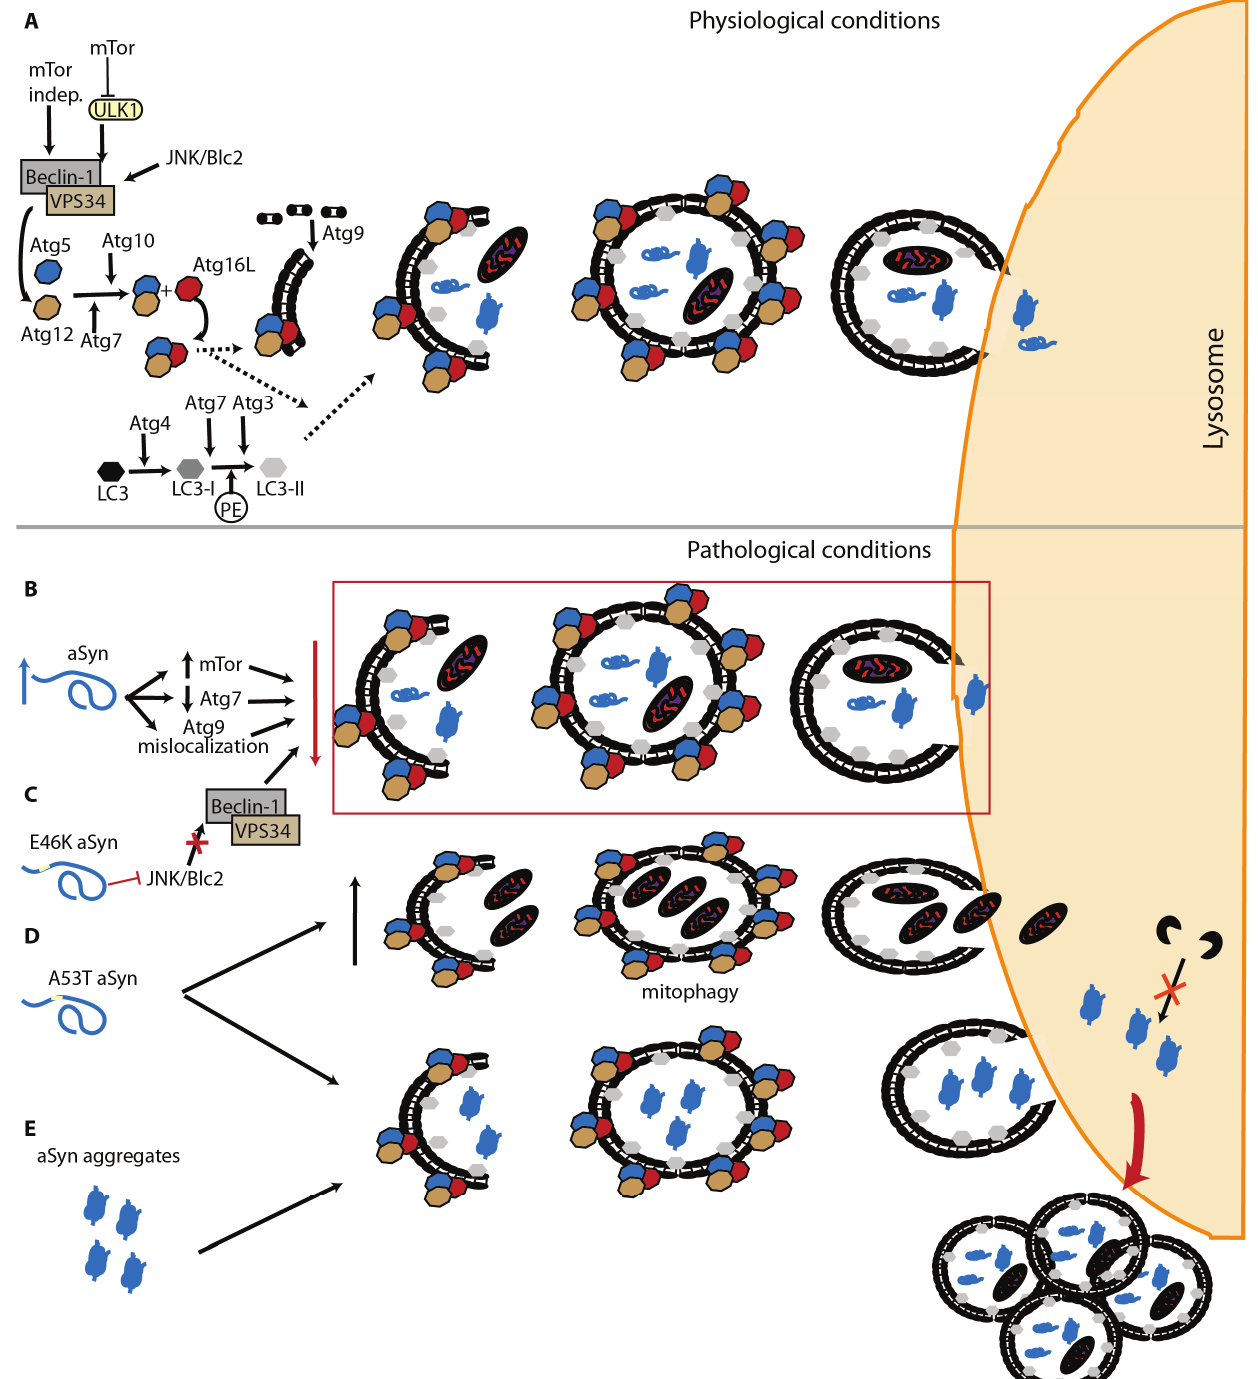
Figure 2. (cid:2)-syn and Macroautophagy. ( A ) Macroautophagy is composed of fine-tuned machinery that ensures specific target recognition and cargo delivery to the lysosome; ( B ) Accumulated (cid:2)-syn increases mTor and decreases Atg7 levels, promoting mislocalization of Atg9 and leading to impairment of macroautophagy; ( C ) The (cid:2)-syn familial mutation E46K can inhibit macroautophagy via JNK/Blc2, an mTor independent pathway; ( D ) On the other hand, two different effects are associated with the A53T (cid:2)-syn mutation: an increase in mitophagy, and accumulation of autophagosomes due to impaired degradation; ( E ) (cid:2)-syn aggregates cannot be degraded by macroautophagy, leading to the impairment of the